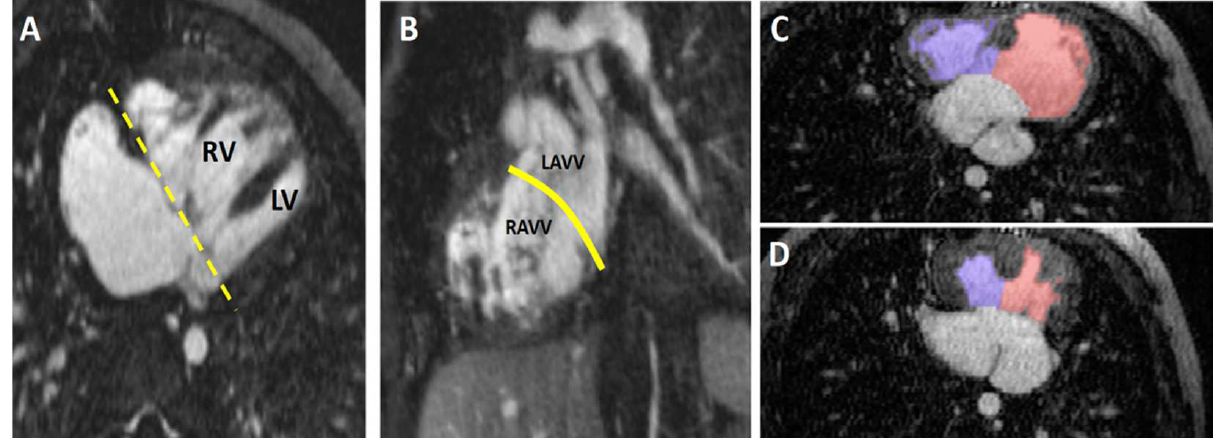
Figure 9. Unbalanced “Right-dominant” Atrioventricular Canal Defect (AVCD). Multiplanar maxi- mum intensity projections from a 4D FE-MRA (MUSCI) study in an infant with unbalanced AVCD and relatively small left ventricle (“right-dominant”). This study was performed to determine can- didacy for a full surgical repair. The left LV is significantly smaller than the RV (Panel ( A )). The dashed yellow line in Panel ( A ) indicates the plane of the short-axis image shown in Panel ( B ). The plane indicating where the interventricular septum should be is depicted by solid yellow line in Panel ( B ). From this short-axis image the asymmetry of the right and left sides of the AV valve, and the relative paucity of LAVV tissue, can be appreciated. Panels ( C , D ) are images from a study in a different patient. LV (red shaded area) and RV (blue shaded area) volumes and ejection fractions were calculated from diastolic (Panel ( C )) and systolic (Panel ( D )) 3D image data taken during steady-state enhancement by ferumoxytol. RV = right ventricle; LV = left ventricle; AV = atrioventricular; LAVV = left atrioventricular valve.